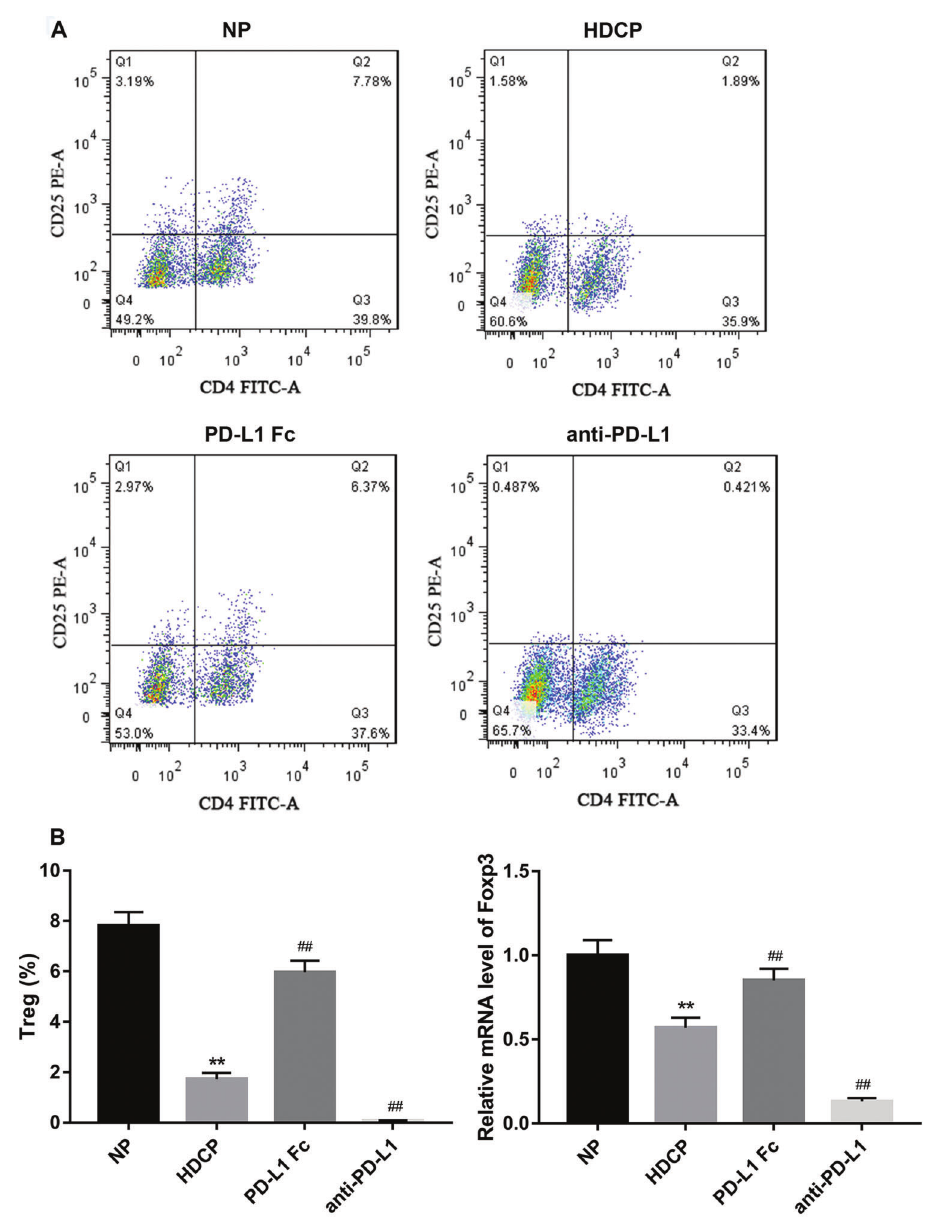
Figure 3. PD-L1 Fc promoted Treg cell differentiation. A , PD-L1 Fc (10 m g/mL) and anti-PD-L1 mAb (10 ng/mL) were added into the isolated peripheral blood mononuclear cells (PBMCs) of women with normal pregnancies (NP) and hypertensive disorder complicating pregnancy (HDCP) and incubated for 3 days. B , The percentage of Treg cell quantities in PBMCs was evaluated by fl ow cytometry and the mRNA level of Foxp3 in PBMCs of women with HDCP was evaluated by qRT-PCR. Data are reported as means ± SD. **P o 0.01 vs NP; ## P o 0.01 vs HDCP ( t